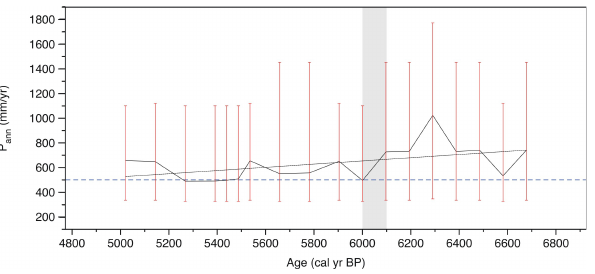
Fig. 9. Reconstructed mean annual precipitation values ( P ann ) for the period recorded in core LT1, Lake Chad, using modern ana- logues technique. Dashed line represents the modern precipitation value measured at the Djamena meteorological station, red line rep- resents the error bars of the precipitation